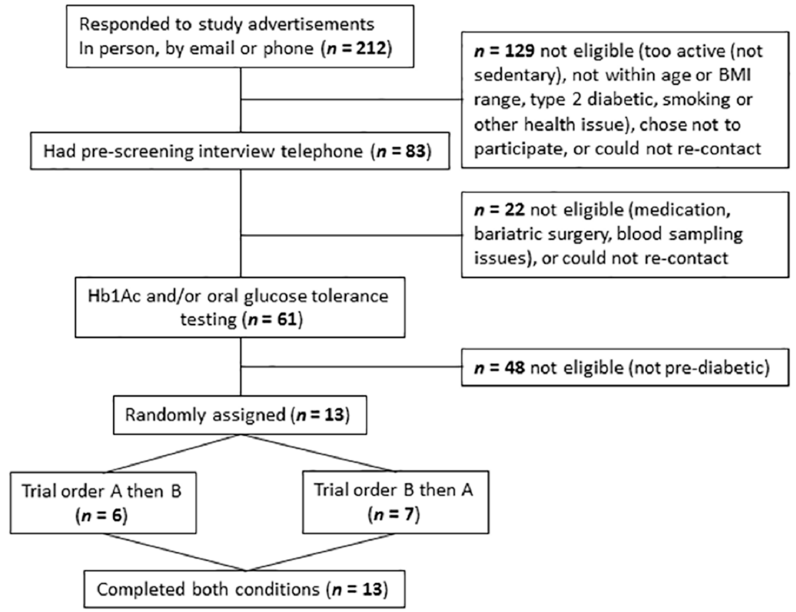
Figure 2. Consolidated Standards of Reporting Trials (CONSORT) flow diagram of participant recruitment. For a full CONSORT statement see Supplementary File S1. Table 1. Anthropometric, biochemical, physical activity and dietary information from participants with prediabetes ( n = 13) prior to each trial condition.